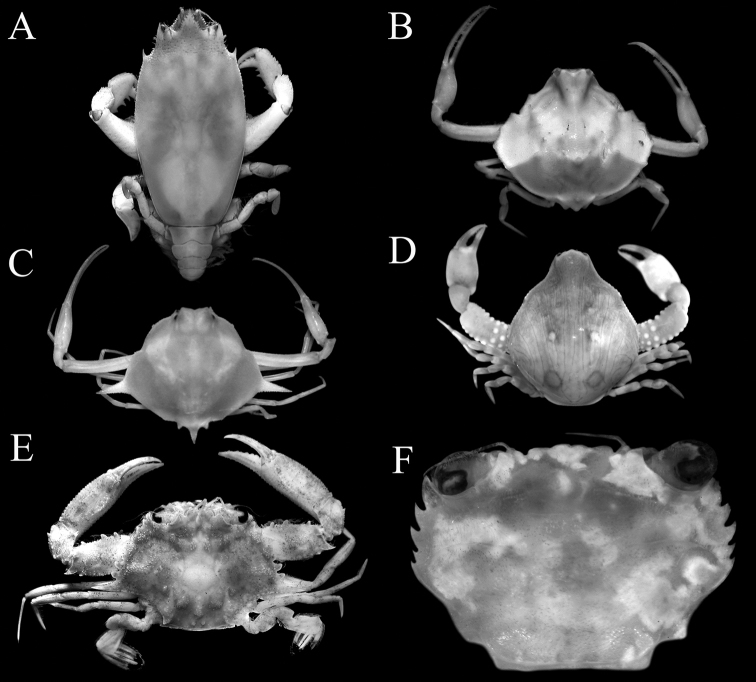
Overall dorsal habitus. ANotoscelesserratifrons (Henderson, 1893), male (9.1 × 17.6 mm) BNursiliatonsor Alcock, 1896, female (6.0 × 5.3 mm) CArcaniagracilis Henderson, 1893, male (7.7 × 5.5 mm) DColeusiaurania (Herbst, 1801), female (10.1 × 12.0 mm) EXiphonectestuberculosus (A. Milne-Edwards, 1861), male (21.1 × 12.4 mm) FThalamitamacrodonta Borradaile, 1902, female (8.4 × 5.8 mm).